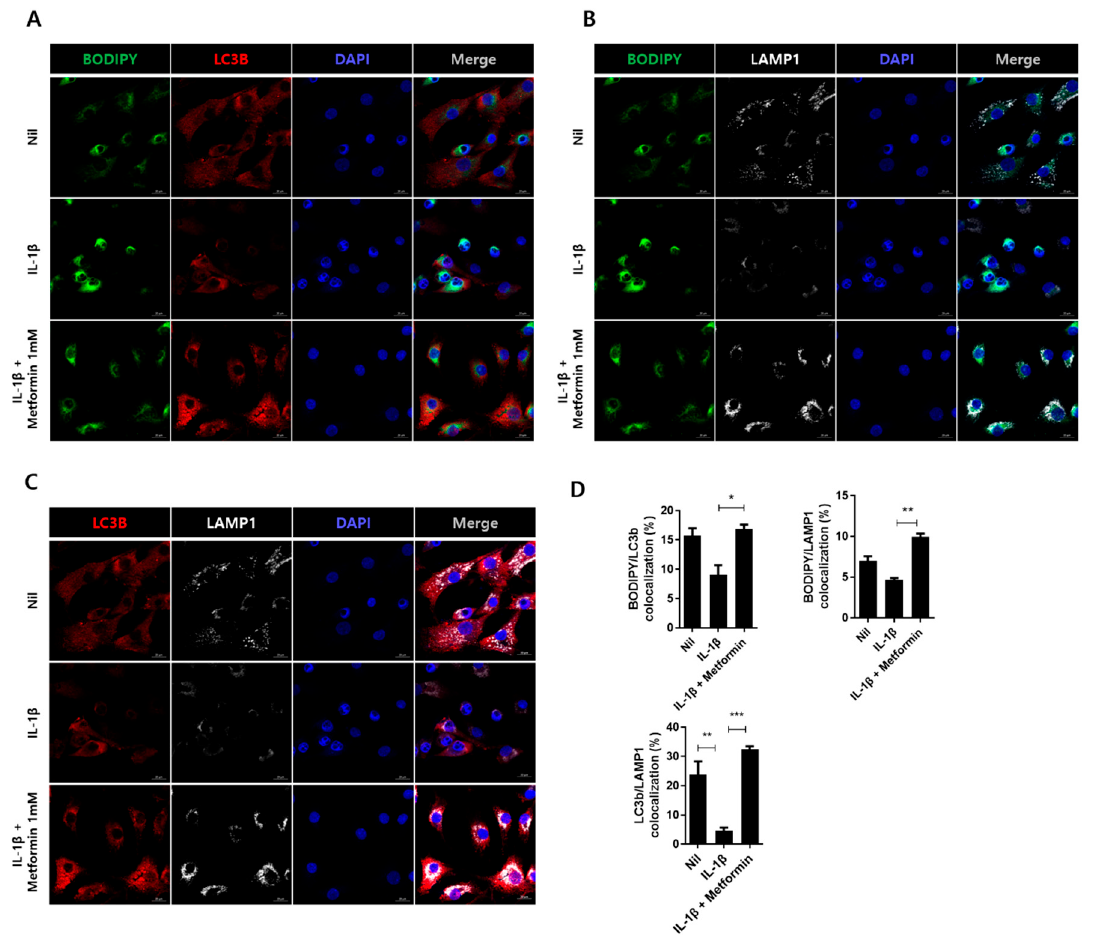
Figure 5. Metformin regulates autophagolysosome via LAMP1 activation. Human chondrocytes were cultured with metformin (1 mM) and IL-1 β (20 ng/mL) for 24 h. The cells were analyzed using confocal microscopy for autophagosome and autophagolysosome. For autophagosome structure analysis, ( A ) colocalization of BODIPY (green) and LC3B (red) were analyzed in unstimulated (Nil) or each stimulated human chondrocyte ( B , C ) for autophagolysosome, colocalization of BODIPY (green), and LAMP1 (white) or colocalization of LC3B (red) and LAMP1 (white). ( D ) Colocalization fluorescence was analyzed using the Fiji/ImageJ program. The data are a repeat of three independent experiments, and the fluorescent data are presented as the mean ± SEM of three independent experiments (* p < 0.05, ** p < 0.01, *** p <